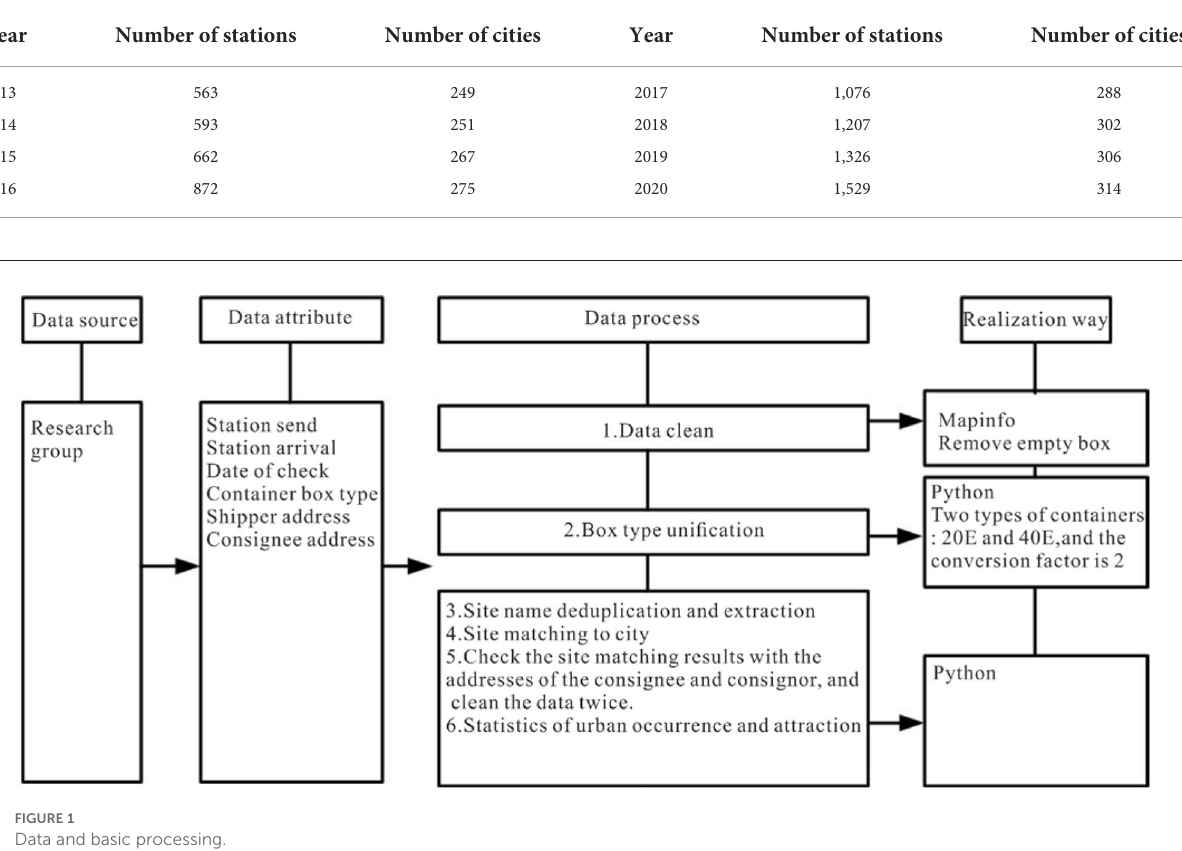
TABLE 1 Basic attributes of research data.